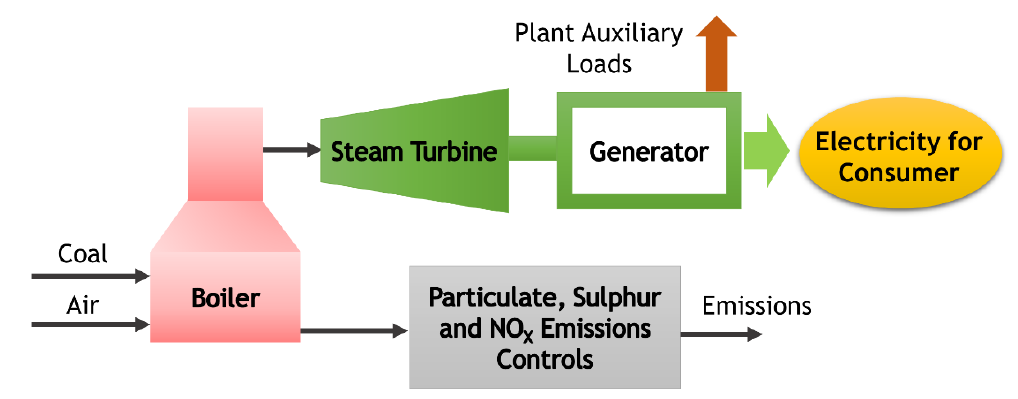
Figure 3. Schematic of the supercritical pulverized coal-fired power plant (SCPC).